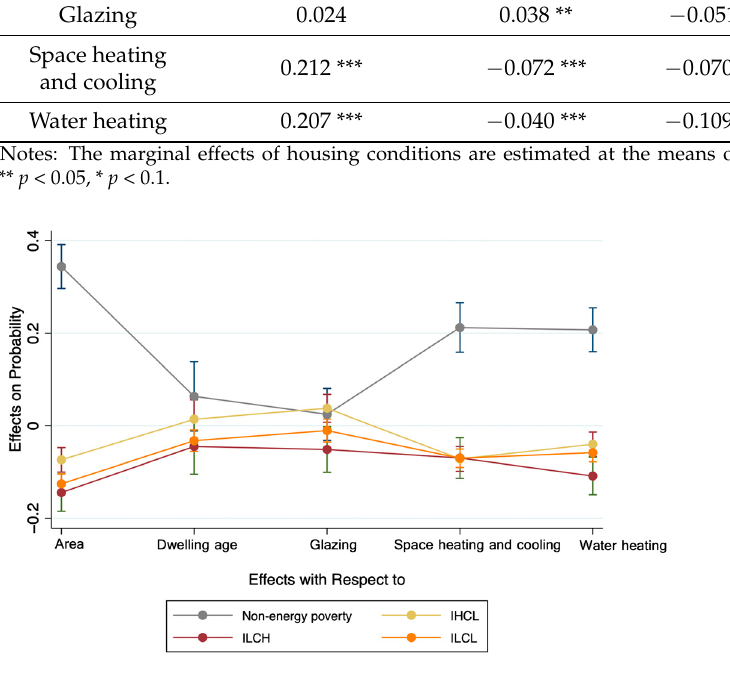
Figure 3. Marginal